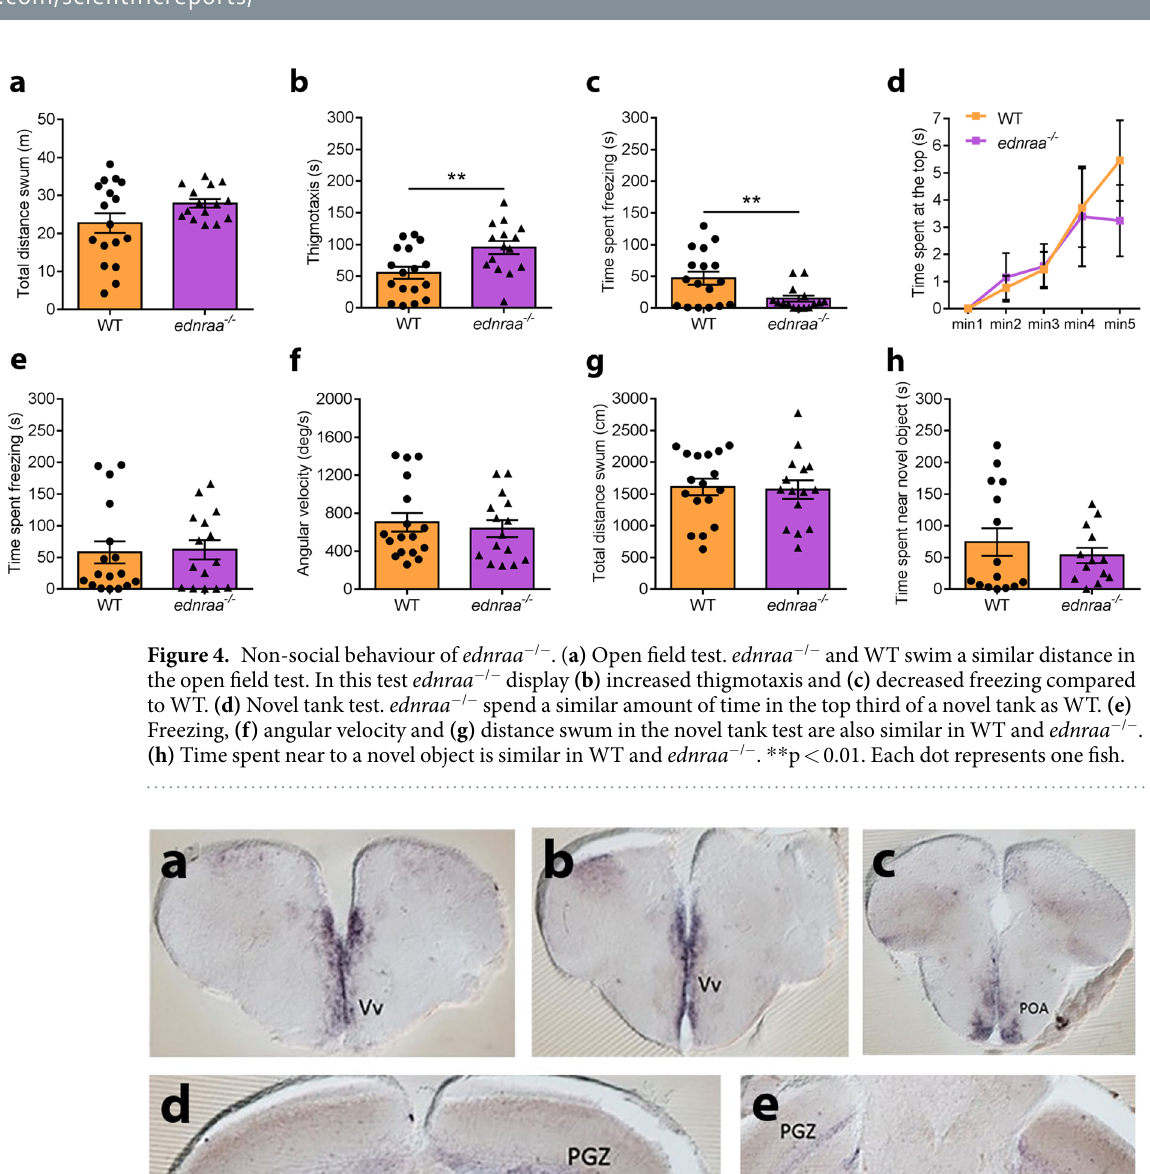
and position of POA AVP neurons correlate with aggression and social dominance in zebrafish 37 . This makes AVP an ideal candidate to underpin the behavioural phenotype of ednraa − / − . We first examined the expression of edn- raa mRNA in the adult zebrafish brain (Fig. 5a-e). ednraa mRNA was expressed in the ventral zone of the ventral telencephalon, the POA, dorsal thalamus, periaqueductal grey, ventral hypothalamus and periventricular nucleus of the hypothalamus (PVN), areas of the brain that are important for social behaviour. We next examined expres- sion of the genes coding for AVP and OXT by in situ hybridisation. At 6 and 12 days post-fertilisation arginine vasopressin ( avp ) mRNA expression in the POA was similar in WT and ednraa − / − mutant zebrafish (Fig. 6a–d).